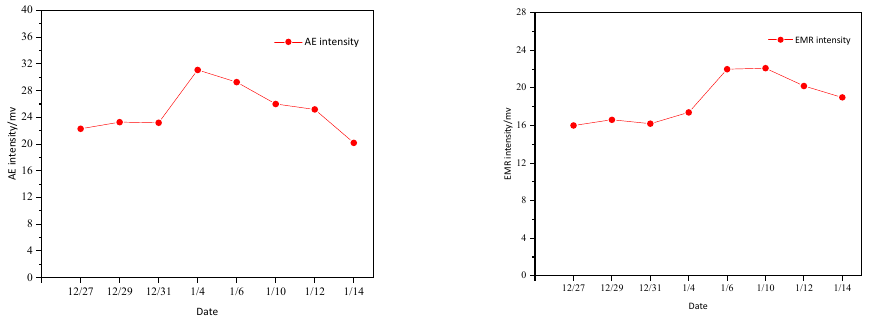
Figure 9. Acoustoelectric monitoring rules.